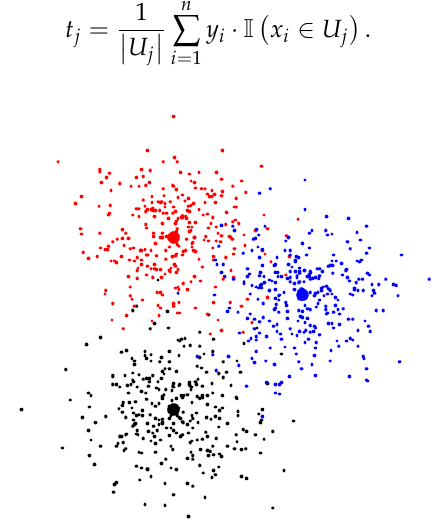
Figure 2. The most remarkable characteristics of the class are supposed to be reflected by the main samples of a